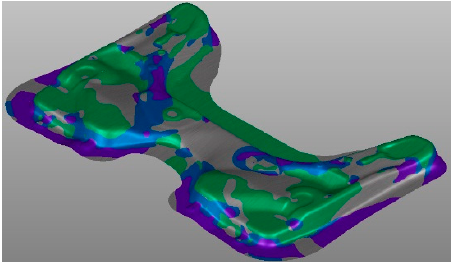
Figure 7. Formability map on component at the end of drawing phase.